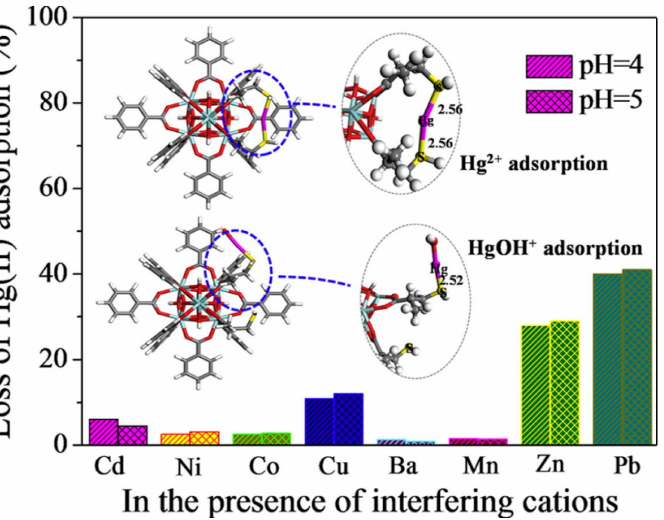
Figure 6. Schematic diagram of UiO-66-SH selective adsorption of Hg 2+ at different pH values. Reprinted with permission from Ref. [97]. Copyright 2018,